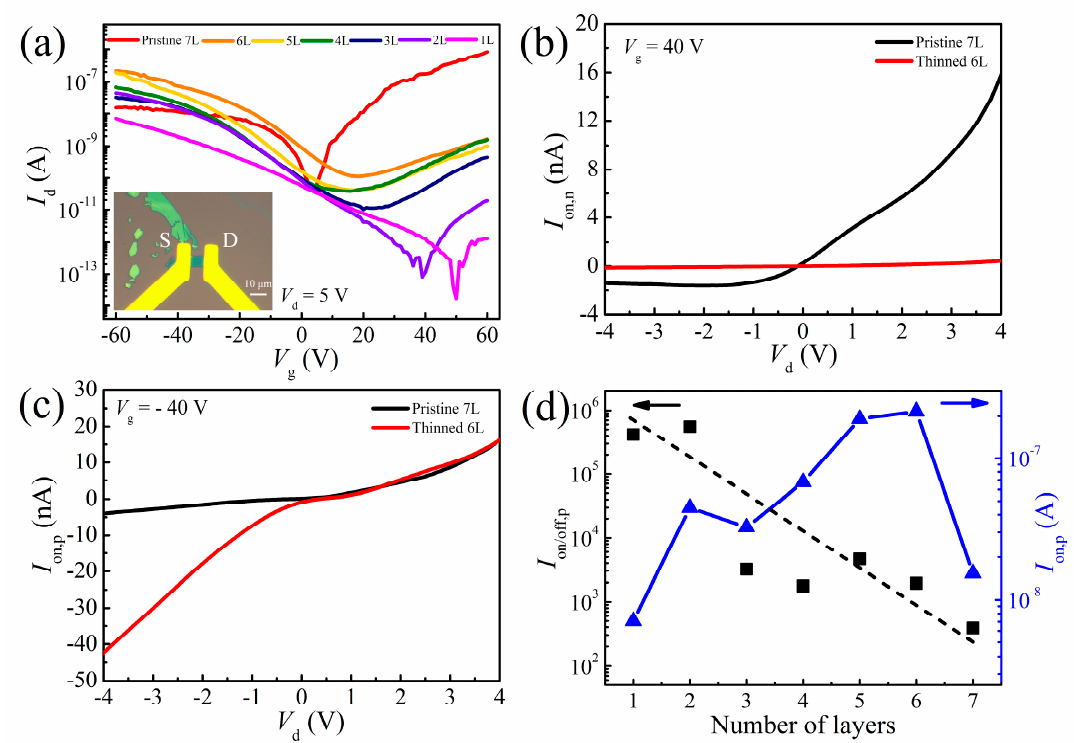
Figure 7. ( a ) Transfer characteristics of a 7L MoTe 2 field effect transistor (FET) before and after layer-by-layer thinning. The inset is an optical image of the as-fabricated device. ( b , c ) Comparison of the output characteristics in the n- and p-type regimes before and after layer thinning. ( d ) I on/off,p (left) and I on,p extracted at V g = − 60 V in (a) (right) plotted as a function of the number of MoTe 2 layers. The dashed line is a guide to the eye.